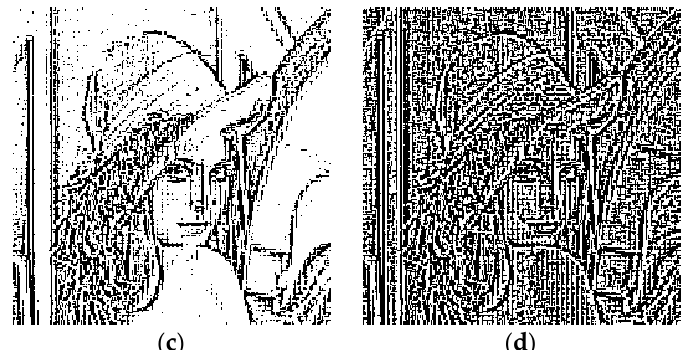
Figure 3. Image segmentation results for different threshold T : ( a ) T = 0.2; ( b ) T = 0.22; ( c ) T = 0.24; ( d ) T =